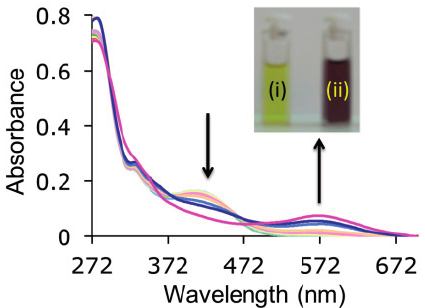
Figure 7. Evolution of UV-vis spectra of 3 (10 − 5 M) upon titration with hydrogenpyrophosphate in DMSO. Inset: Colour change of receptor 3 (i) after the addition 3 − O of HP 2 7